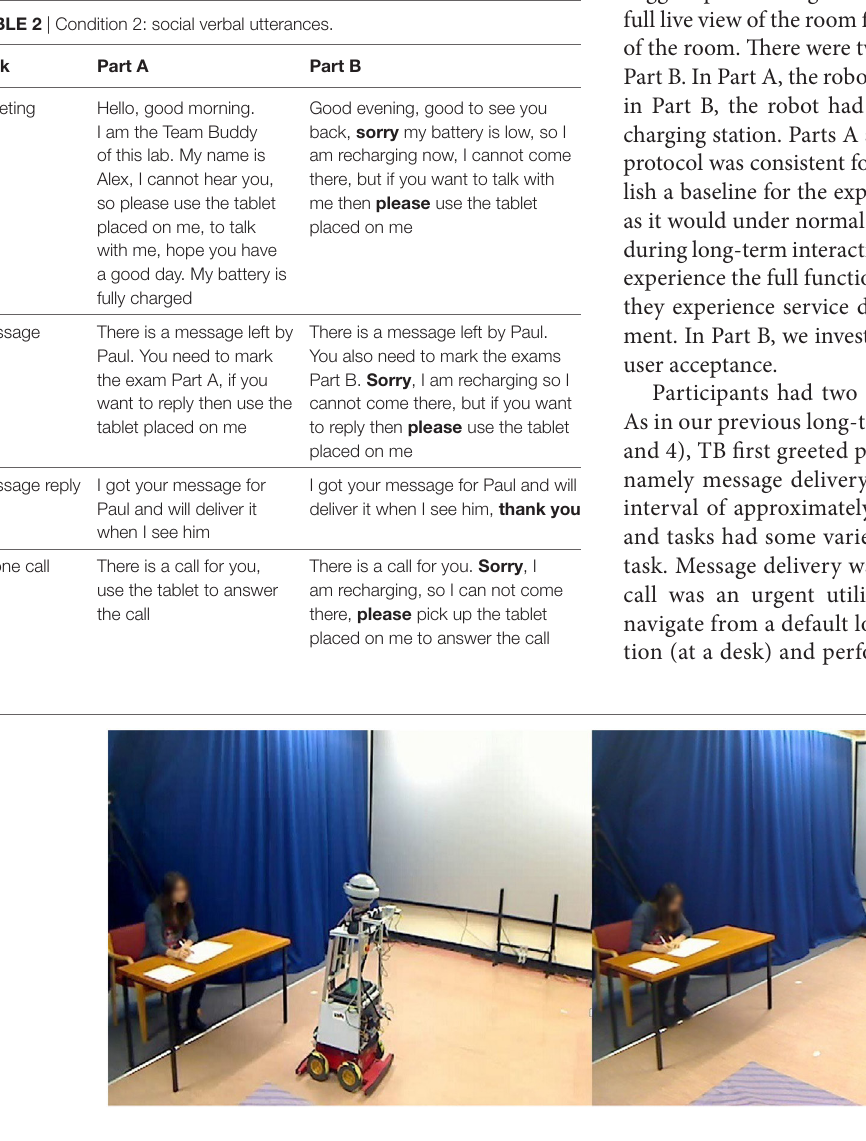
FigUre 6 | Left: part A—Mobile TB and right: part B—Stationary TB (N.B.: the participant in the picture gave her written consent for her picture to be